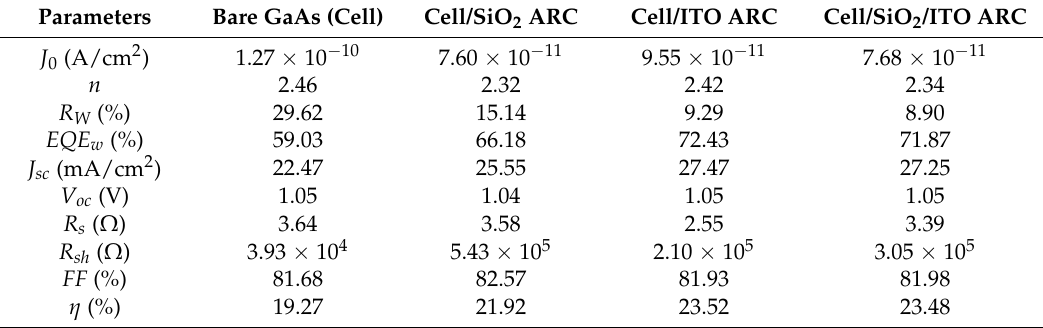
Figure 8. Photovoltaic current density-voltage (J-V) curves of bare GaAs solar cell and cells with ARCs of SiO 2 ARC, ITO, and thin-SiO 2 /ITO. Table 1. Electrical, optical, and photovoltaic performance of all cells examined in this study.